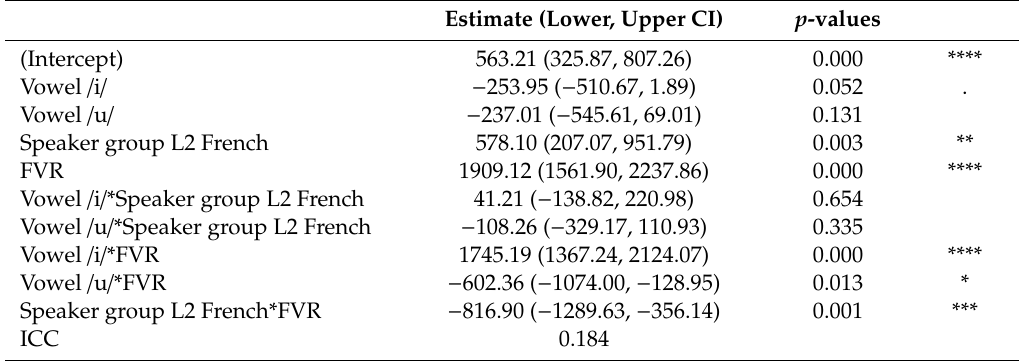
Table 3. Mixed-e ff ects linear regression model for COG at Timepoint